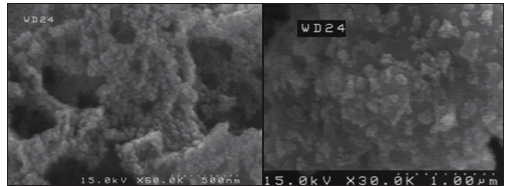
F 2: Two FESEM images of ZnO nanoparticles.